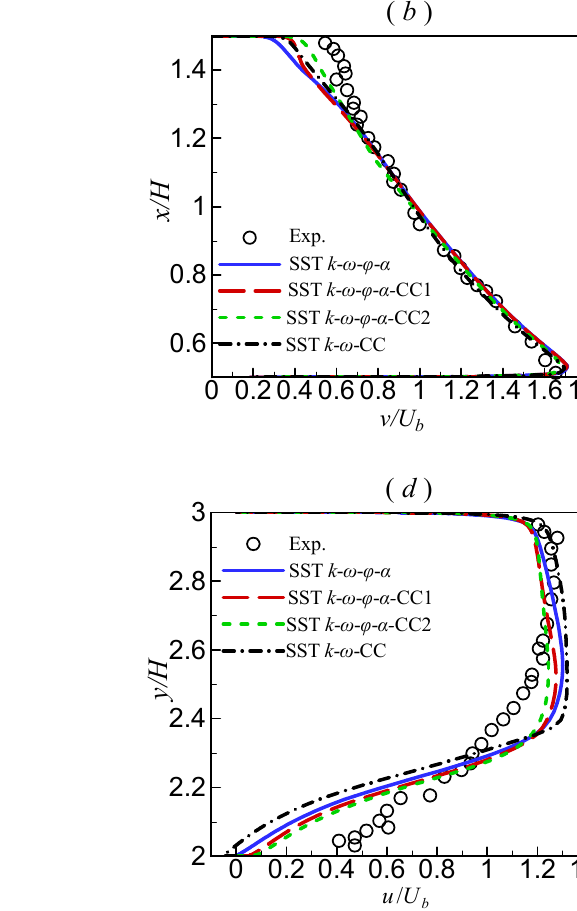
Figure 8. Comparison of turbulent kinetics along different transverse lines for the 2D U ‐ turn duct flow: ( a ) 2/  s/H , and ( b )  s/H . The distributions of the friction coefficients ( 𝐶 (cid:3033) (cid:3404) 2𝜏 (cid:3050) (cid:4666)𝜌𝑈 (cid:3029) (cid:2870) (cid:4667)⁄ ) along the inner and outer walls are depicted in Figure 9. The 𝐶 (cid:3033) along the inner wall, predicted by the differ ‐ ent turbulence models, varied little. The recovery of 𝐶 (cid:3033) downstream in the re ‐ circulation